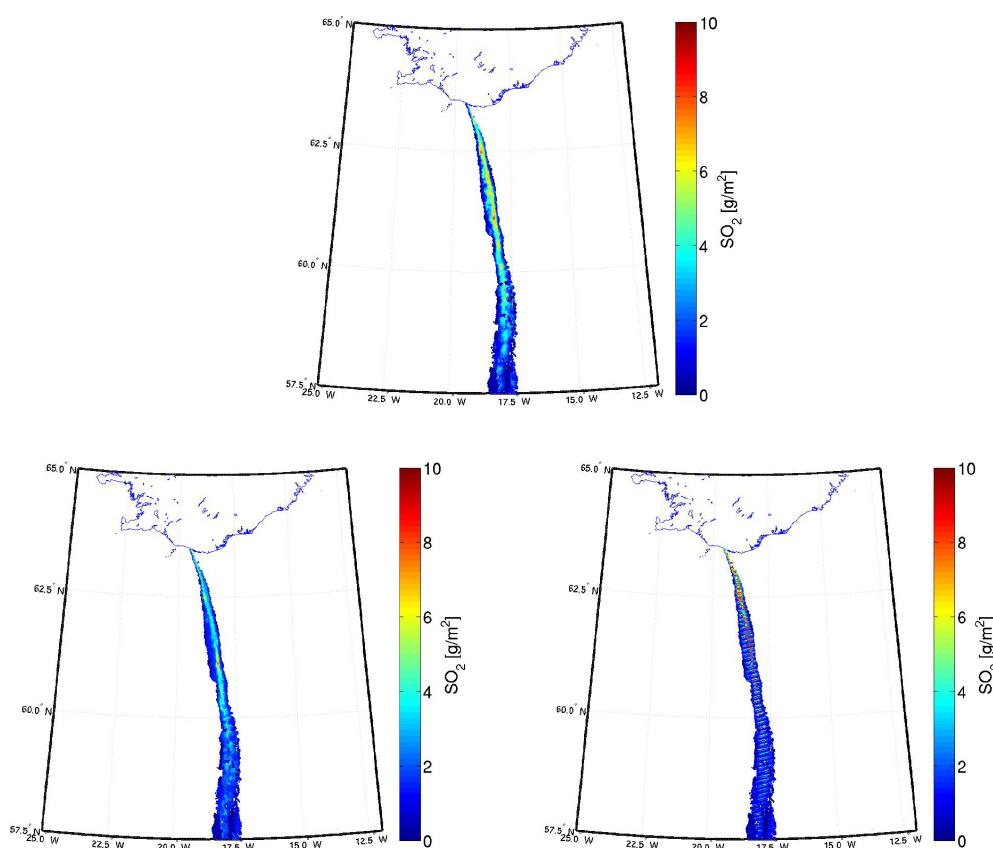
Figure 20. SO 2 columnar abundance maps for 11 May 2010: top, target retrieval; bottom left, retrieval from 3 inputs neural network; bottom right, retrieval from pruned neural